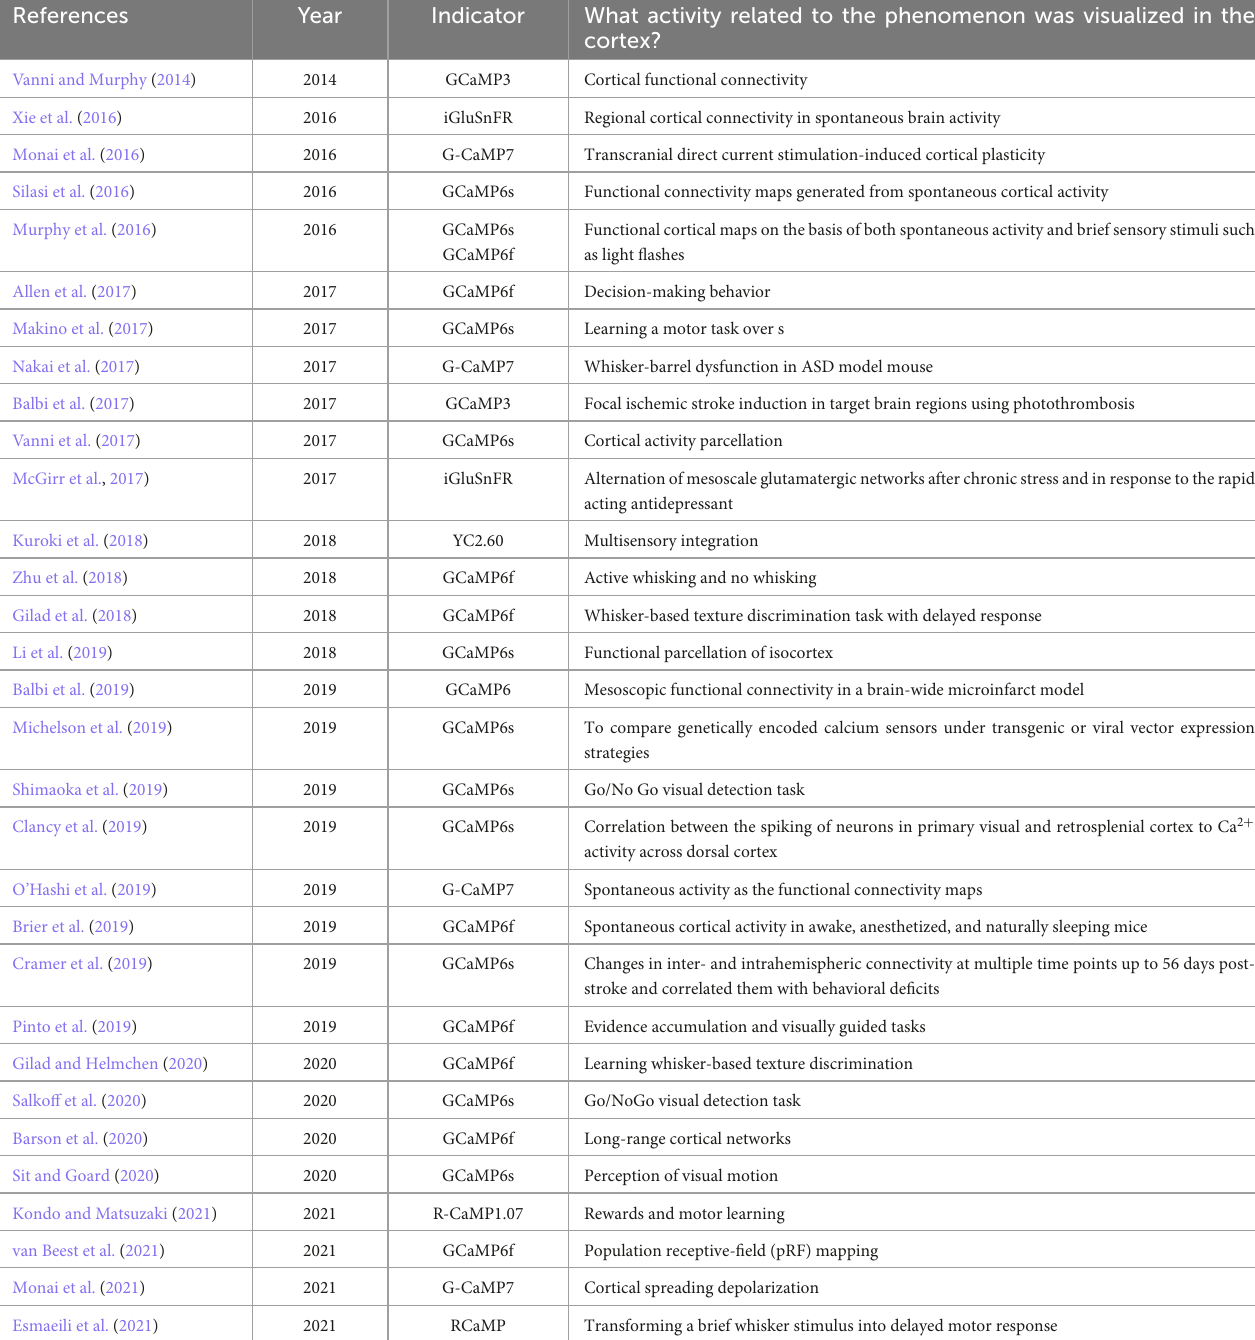
TABLE 1 The primary references of the cortex-wide transcranial Ca 2 +